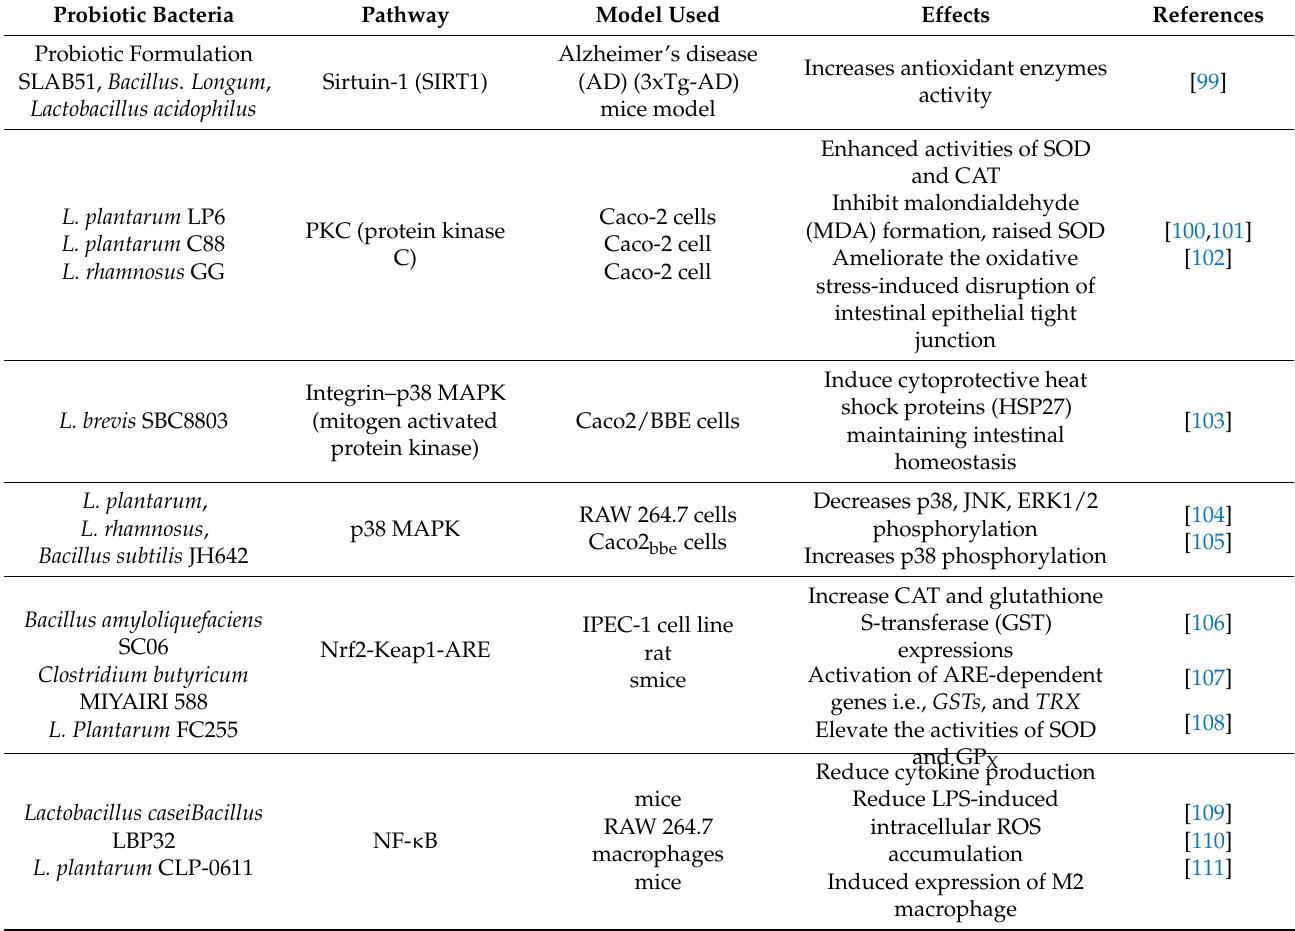
Table 3. Some antioxidant probiotic bacteria with the signaling pathways used to activate antioxidant enzymes and